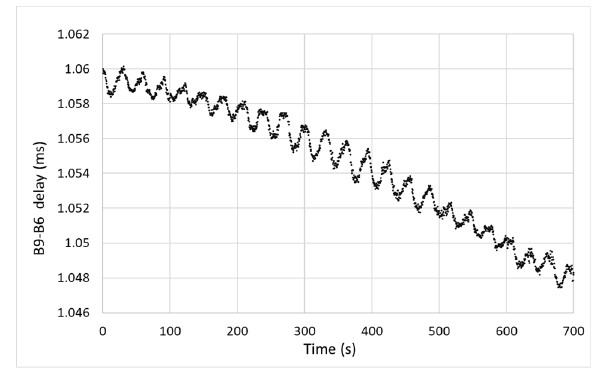
Figure 13 : Impact of solar generator vibrations on B6-B9